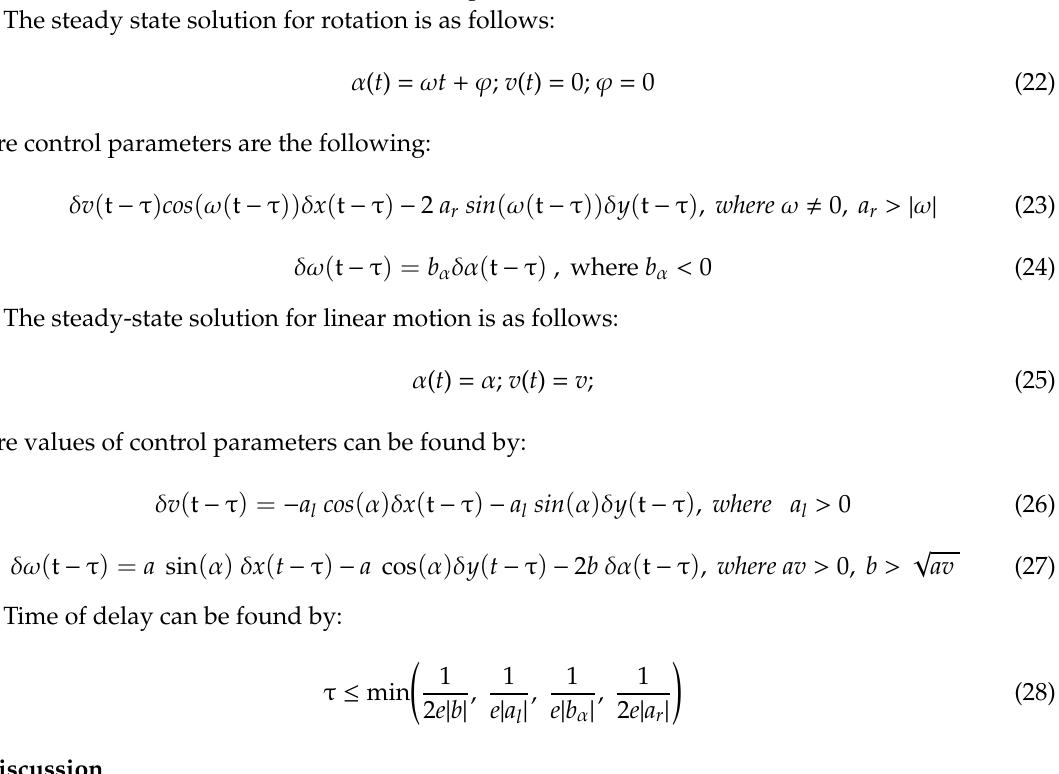
Figure 8. Automatic control: the ground robot has output parameters (output of block 1) describing its position, orientation, and velocity. These parameters are measured and calculated by the measurement system with some time delay (output of block 2). These measured parameters and their desirable values, calculated from the desirable trajectory (inputs of block 3), can be compared, and deviation from desirable trajectory can be calculated (output of block 3). The automatic pilot receives these deviations and calculates the control parameters for the ground robot to decrease these deviations. Then the ground robot changes its output parameters (output of block 1). This cycle repeats for the duration of the motion.